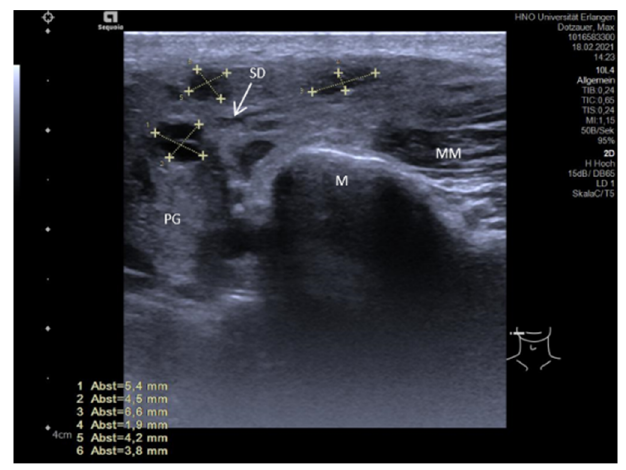
Figure 7. A case of chronic recurrent parotitis with sialectatic sialodochitis is shown. The parenchyma is slightly hypoechoic. No pronounced dilation of the main parotid duct is recognizable (white arrow). Multiple nearly anechoic formations are visible. Because no internal echoes were detectable, but connections to the main duct system were noted, the presence of sialectatic sialodochitis was diagnosed. Abbreviations: PG, parotid gland; M, mandible; MM, masseter muscle; SD, Stensen ´ s duct.